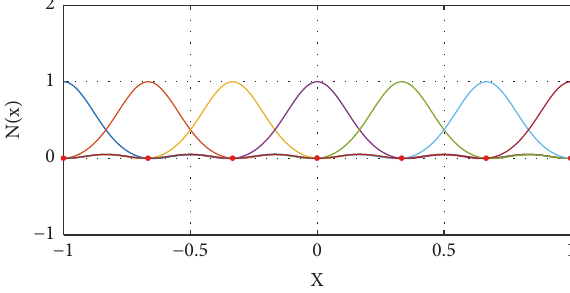
Figure 2: Kriging shape functions using 𝜎 = (1/3)√(𝑥 𝑖+1 − 𝑥 𝑖 ) 2 for 7 control points uniformly distributed along the 1D